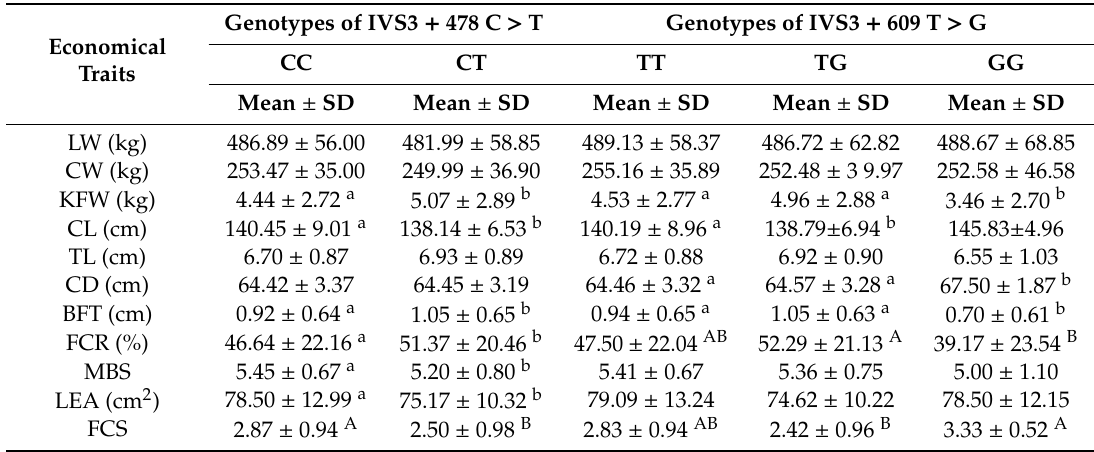
Table 3. Association of two SNPs of the bovine DLK1 gene with economical traits in Chinese Simmental.